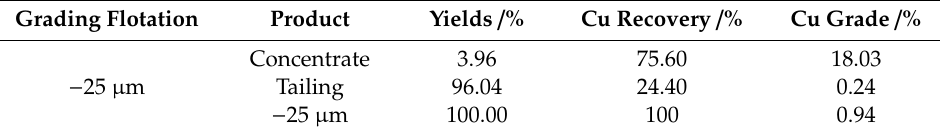
Table 5. Flotation grade and recovery of − 25 µ m malachite.